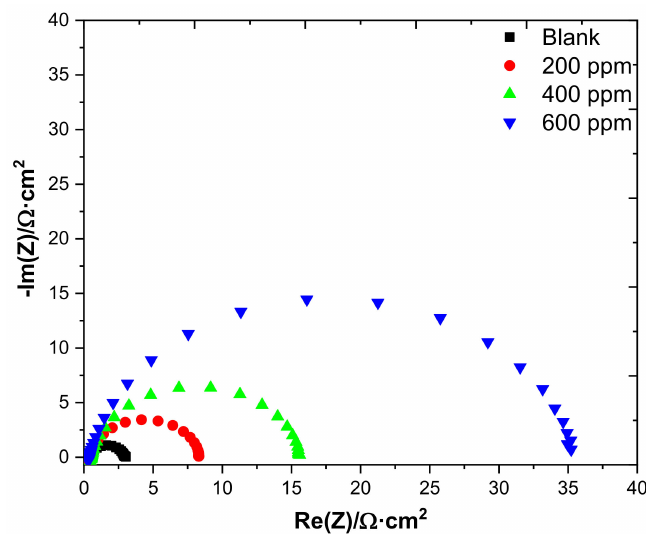
Figure 9. Nyquist plot of mild steel in 1 M HCl at different concentrations of PBSLP with a sinusoidal potential of 5 mV.